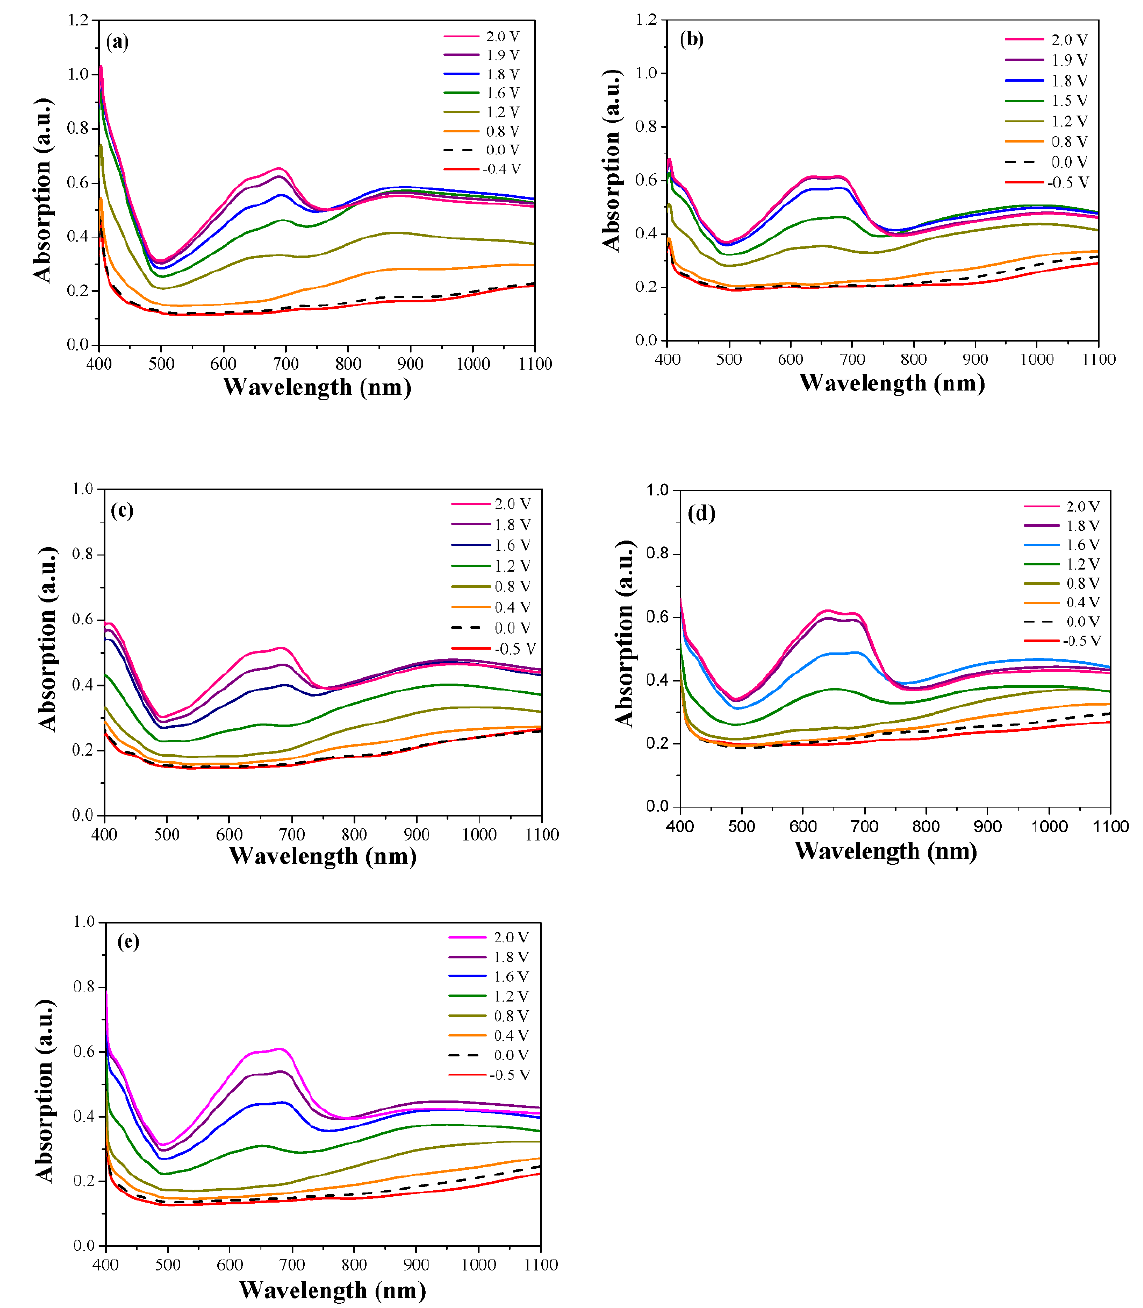
Figure 7. UV–Visible plots of the ( a ) P(DCB)/PEDOT-PSS, ( b ) P(DCB- co -ED)/PEDOT-PSS, ( c ) P(2DCB- co -ED)/PEDOT-PSS, ( d ) P(DCB- co -EDm)/PEDOT-PSS, and ( e ) P(2DCB- co -EDm)/PEDOT- PSS devices. The P(DCB)/PEDOT-PSS ECD was bright gray at − 0.5 V, dim gray at 1.2 V, and army blue at 2.0 V . The P(DCB- co -ED)/PEDOT-PSS ECD was silver gray at − 0.7 V, bright slate gray at 1.2 V, and saxe blue at 2.0 V. The P(2DCB- co -ED)/PEDOT-PSS ECD was light gray at − 0.5 V, azure at 1.8 V, and Wedgwood blue at 2.0 V. The P(DCB- co -EDm)/PEDOT-PSS ECD was Gainsboro gray at − 1.0 V, army at 1.6 V, and grayish blue at 2.0 V. The P(2DCB- co -EDm)/PEDOT-PSS ECD was slate gray at − 1.0 V, gray at 1.6 V, and peacock blue at 2.0 V. The chromaticity diagrams of P(DCB)/PEDOT-PSS, P(DCB- co -ED)/PEDOT-PSS, P(2DCB- co -ED)/PEDOT-PSS, P(DCB- co -EDm)/PEDOT-PSS, and P(2DCB- co -EDm)/PE- DOT-PSS ECDs at several potentials are shown in Table 5.